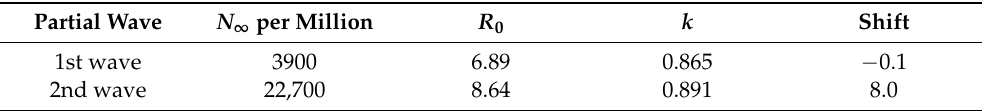
Table 3. The parameters of the Gompertz curves in the Omicron surge in Shanghai. The definition of the parameters is the same as in Table 1, but the reference date is 18 March